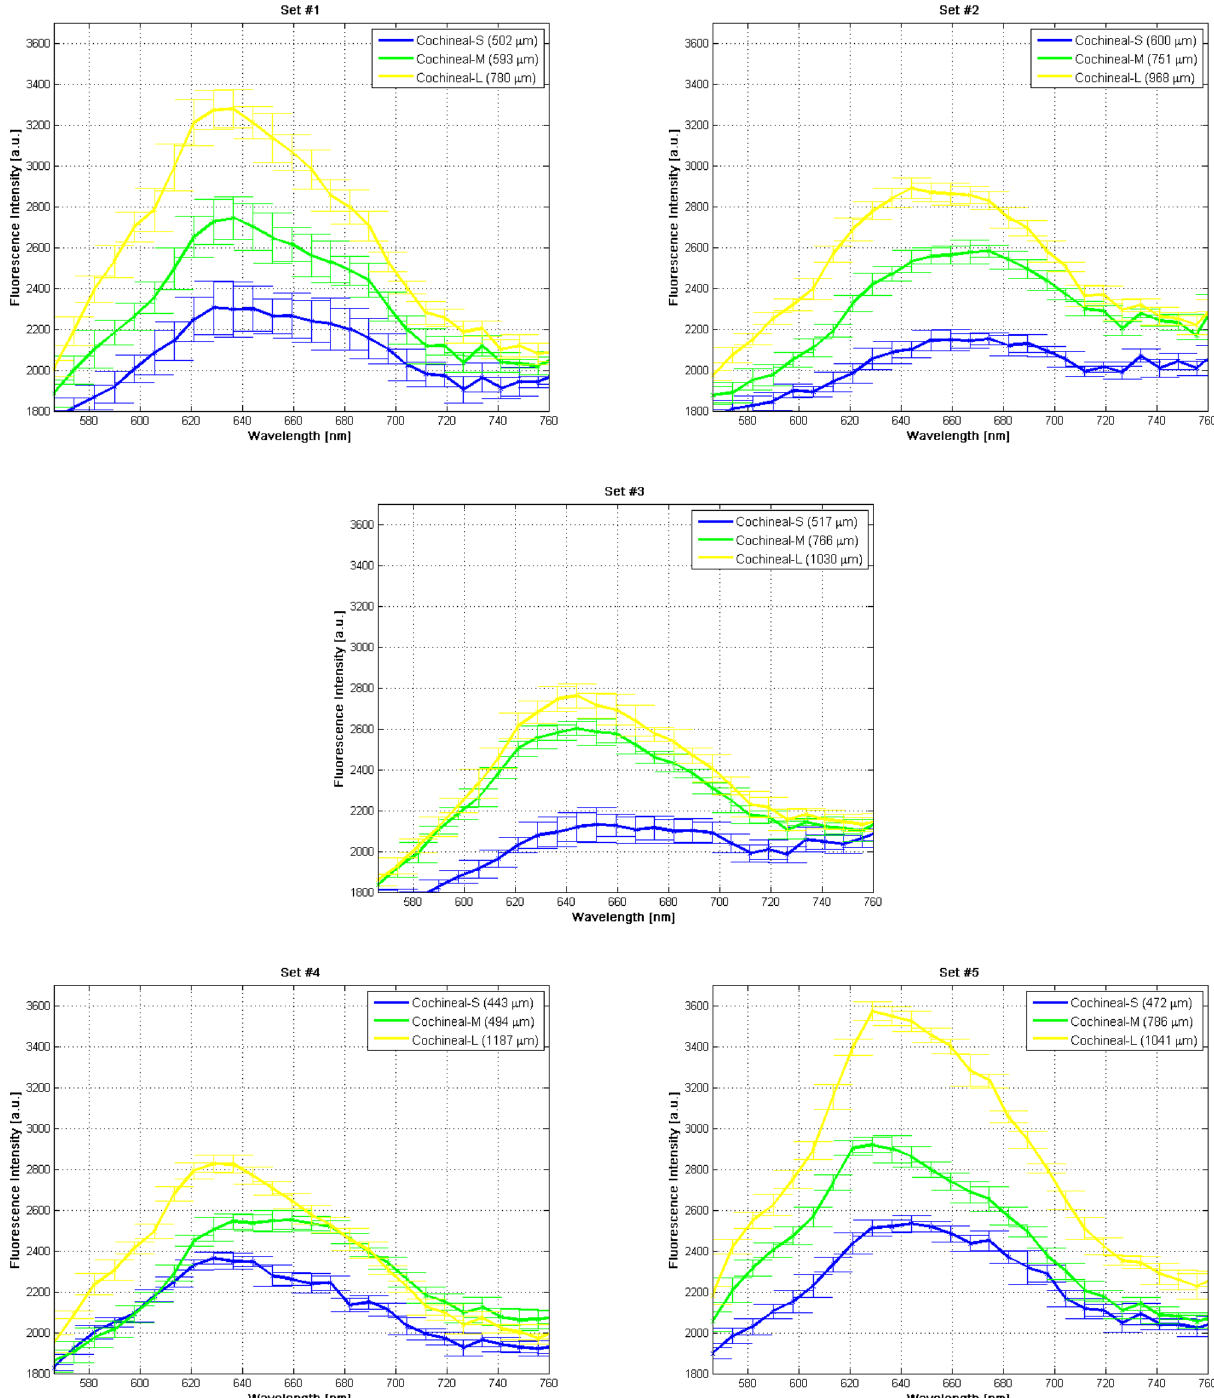
Figure 2. Graphical comparison of in-vivo fluorescence spectra of wild cochineals of different sizes for the five sets of biological samples described in section "Materials and